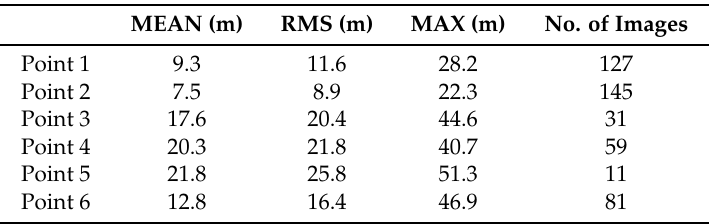
Table 8. Statistic of distance from mapped points to the real position.